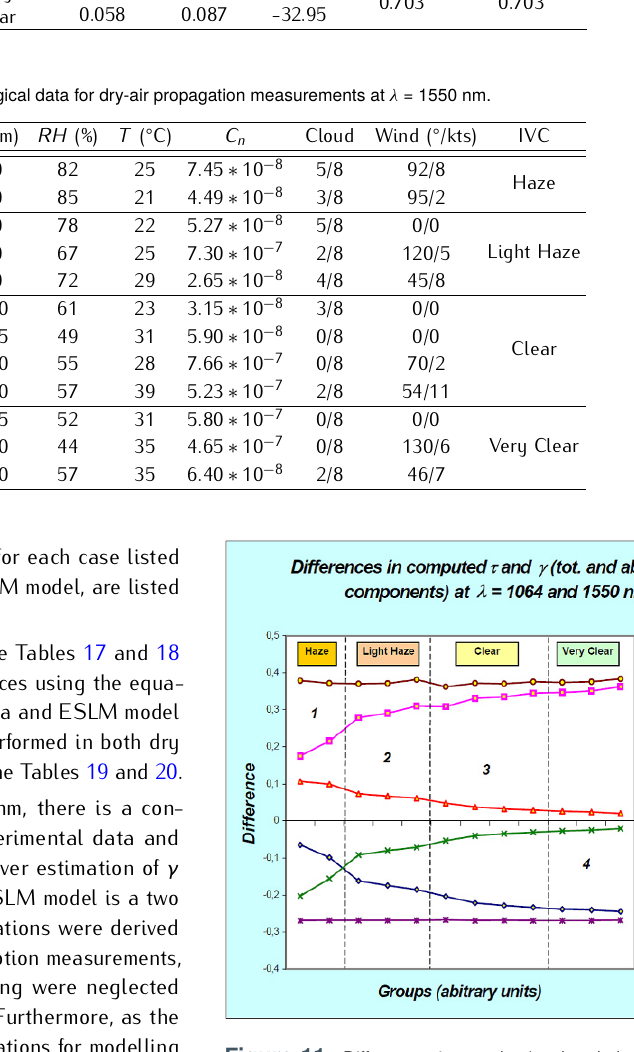
Figure 11. Differences in τ and γ (total and absorptive/scattering components) computed with the ESLM model for λ = 1064 nm and λ = 1550